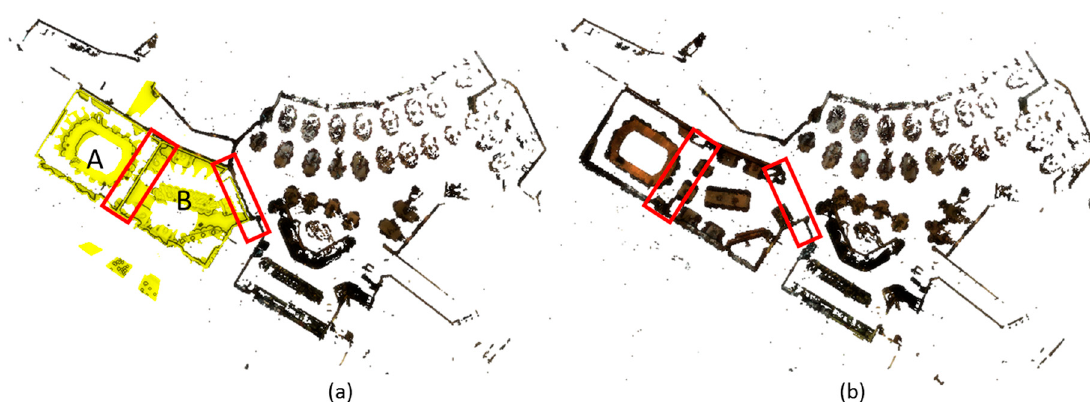
Figure 13. The figure shows the top view of two epochs of our use case. The floor and ceiling are removed for a clear visualization. ( a ) The data is collected by a Riegl terrestrial laser scanners (TLS) [45] (rooms A and B in yellow) and is co-registered with the data collected by the Viametris system [56]. ( b ) The second epoch is also collected by the Viametris system and the walls in the red rectangles are